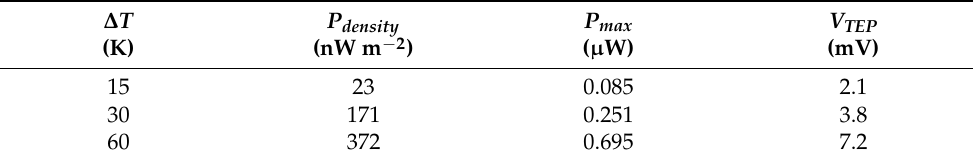
Table 4. Maximum electrical power output, power density, and thermoelectric power voltage of the SWCNT-alkali-activated TEG.